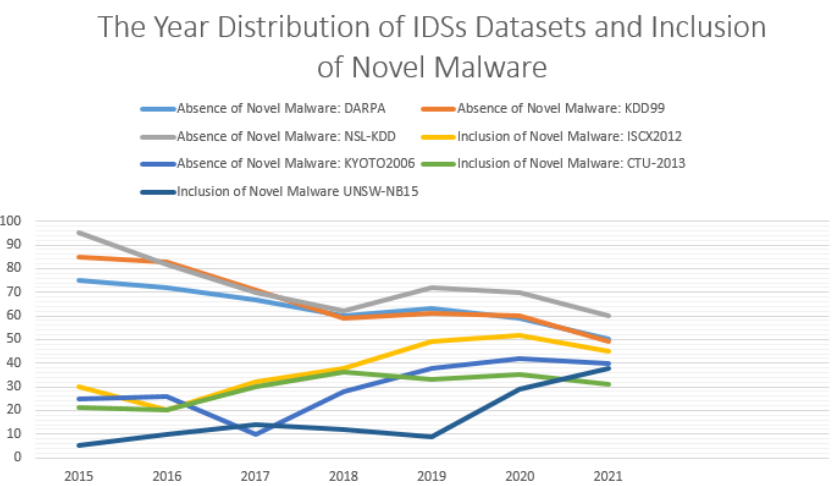
Figure 1. Outdated datasets for the NIDP. The DARPA, KDD99, and NSL-KDD datasets are the most utilised in the current NIDL.